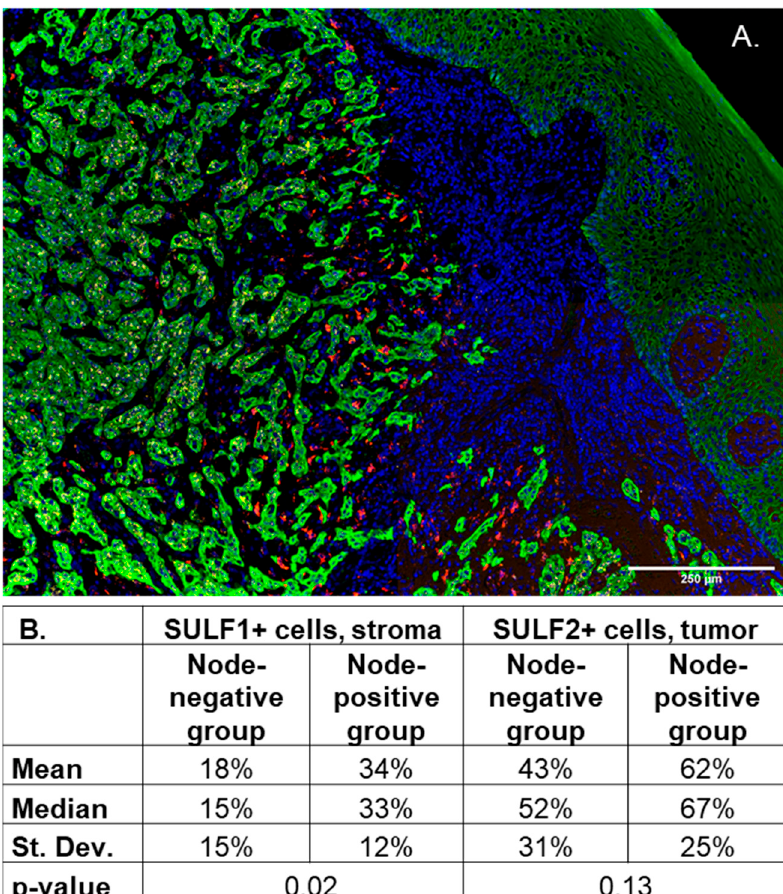
Figure 6. RNAScope of OSCC tumors: ( A ) a tongue cancer stained for DAPI (blue), cytokeratin (green), and with in situ probes for SULF1 (red) and SULF2 (yellow). SULF1 localizes to the stroma, and SULF2 is expressed mainly in the tumor epithelial cells. Adjacent normal tissue is mostly negative for both SULF1 and SULF2; ( B ) comparison of SULF1+ and SULF2+ cell counts in the cancer cell (cytokeratin+) and adjacent stroma (cytokeratin-) of OSCC patients (n = 20). Percentage of SULF1+ cells in the stroma is significantly higher ( p = 0.023) in node-positive patients (n = 10) with poor survival than in node-negative (n = 10) patients with good survival. SULF2* cells in the tumor follow a similar trend but the difference is not